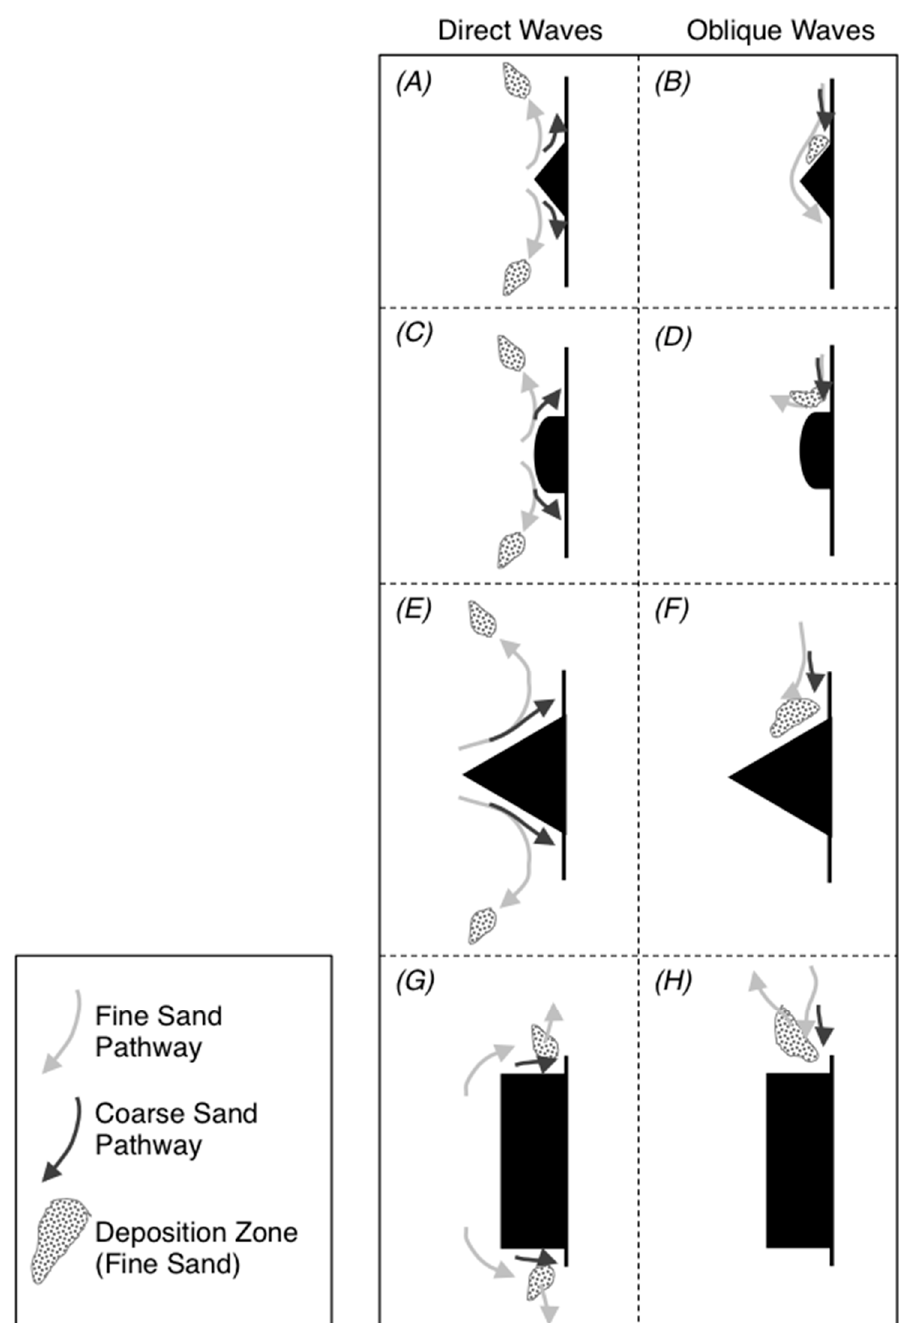
Figure 10. Conceptual sediment pathways and deposition zones for fine and coarse sediment under direct ( A, C, E, G ) and oblique ( B, D, F, H ) wave angles for the four generalized headlands. Accumulation is not expected in the eddy zones formed by oblique wave angles, which is contrary to the conceptualization about deposition in eddy zones by Guillou and Chapalain [18]. The pathways realign to be alongshore when wave angle shifts to be oblique but the morphology of the headland affects the fate of the sediment. In addition, the scale of the conditions generating eddies should be considered: extreme events on a less than 5% frequency are likely to be strong enough to both mobilize and advect sediment away from the headland. Based on the 5% frequency event modeled in this study, transport of fine sediment occurs around small, pointed headlands (T1) but not large ones (T7 and T8), which create deposition zones on the upstream sides of the headlands. Coarse material is generally prevented from getting around any of the headlands. The partitioning